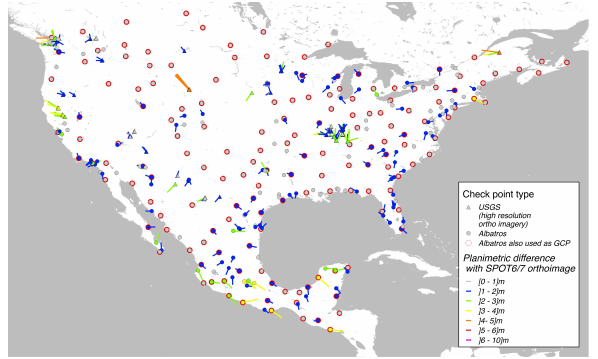
Figure 5. Planimetric check of SPOT 6/7 bundle adjustment